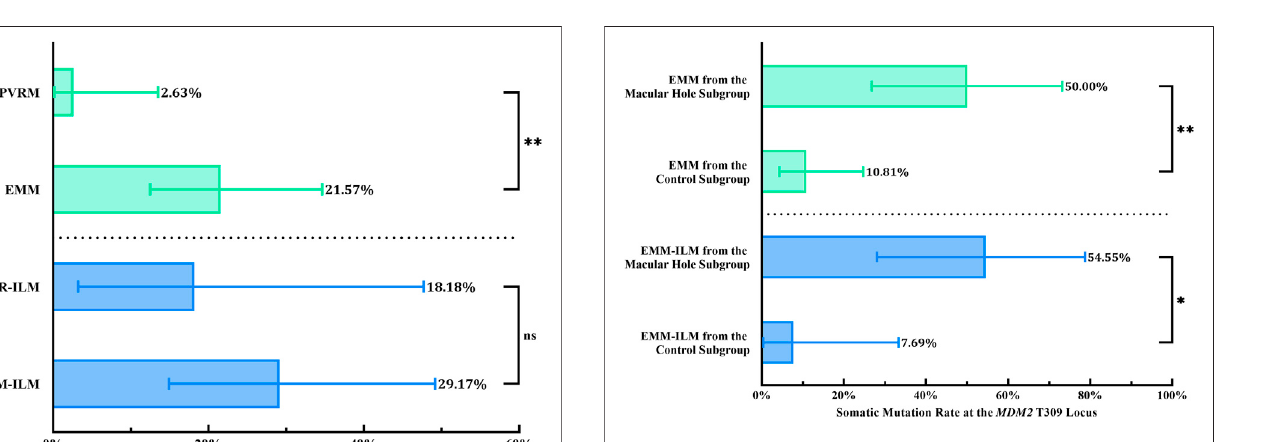
FIGURE7| EMMsandILMsfromEMMcaseswithpreoperativemacular holes tended toward somatic mutation at the MDM2 T309G locus. EMM, epimacular membrane; ILM, internal limiting membrane; MDM2, mouse double minute 2 gene. Asterisks indicate statistical signi fi cance